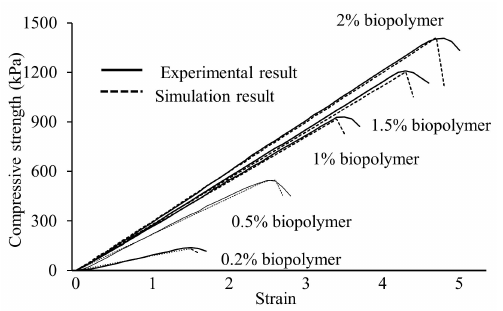
Figure 6. Stress-strain curve of biopolymer treated soil under uniaxial compressive